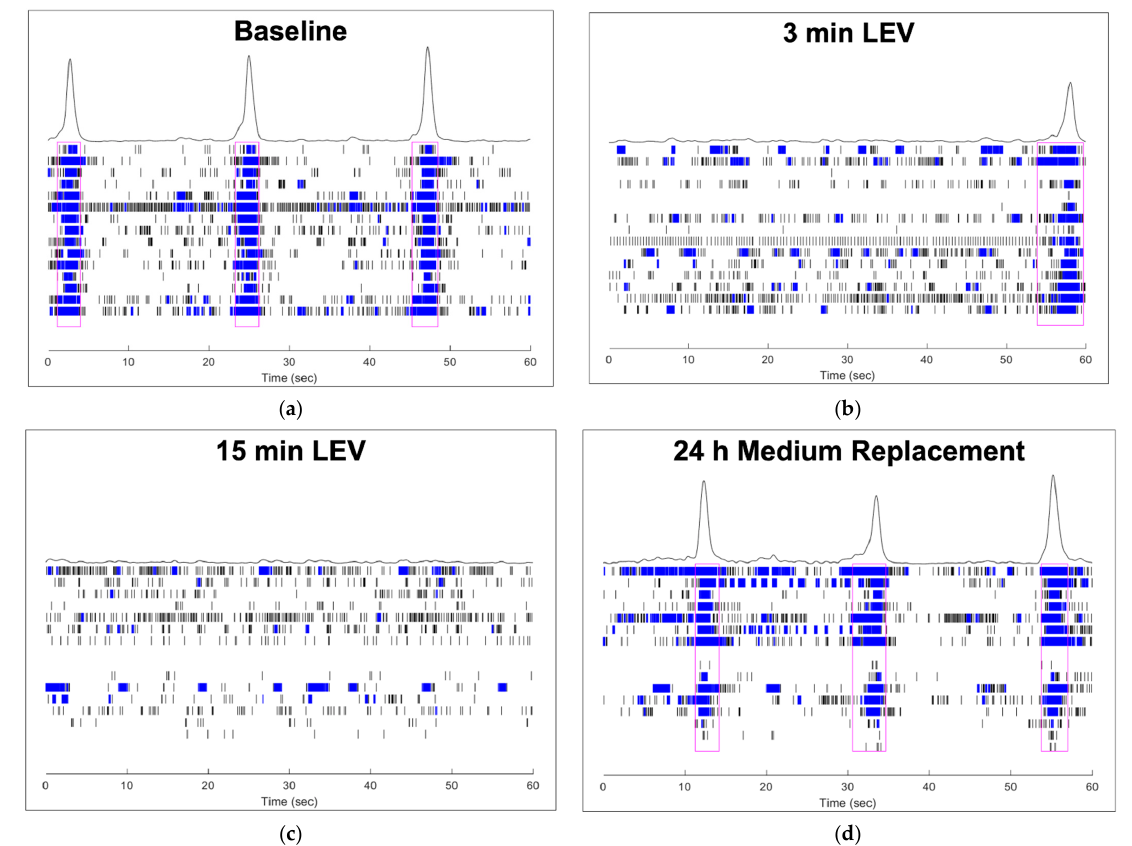
Figure 5. Raster plots: ( a ) baseline; ( b ) 3 min of treatment with LEV; ( c ) 15 min of treatment with LEV; ( d ) recording at 24 h with the basal medium. Black vertical lines indicate the spike occurrence, while blue rectangles represent the single-electrode bursts (clustered spiking activity), that can be of different duration based on how many spikes they contain. In Figure 5a,b,d, network bursts are highlighted by magenta rectangles surrounding the "column" of single-electrode bursts. Every lane of this column (representing the network) corresponds to single-electrode recordings (in this case we used a 24-Well CytoView MEA plate that has 16 electrodes per well). In addition, the peaks over the networks reflect the overall amplitude of network bursts .